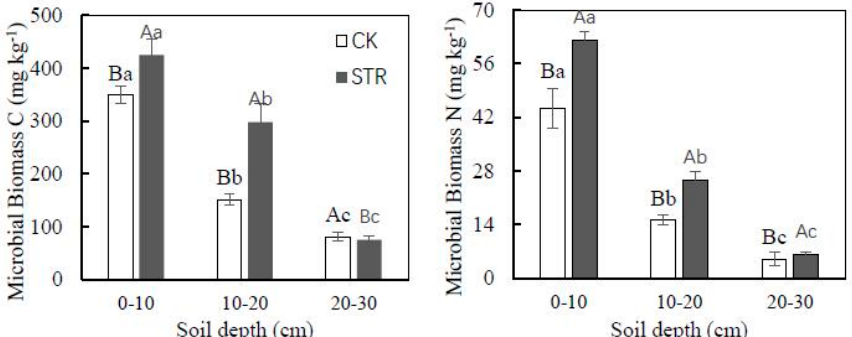
Figure 5. The soil microbial biomass carbon (MBC) and nitrogen (MBN) were affected by straw incorporation (STR), straw removal (CK), and soil depth. Different uppercase letters above the columns for MBC or MBN for the same soil depth indicate a significant difference between treatments ( p < 0.05); different lowercase letters above the columns for MBC or MBN for the same treatment indicate a significant difference between different soil depths ( p < 0.05).